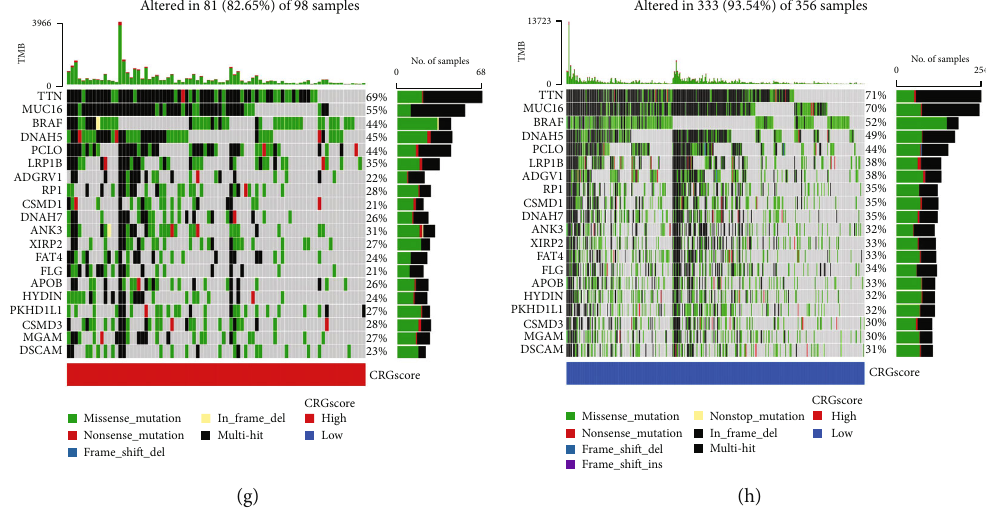
Figure 7: Analysis of the correlation between CRG scores and clinical characteristics. (a – d) K-M survival curves comparing the high CRG score groups to the low CRG score groups across various clinical characteristics. (a) Patients with age > 65 . (b) Patients with age ≤ 65 . (c) Female patients. (d) Male patients. (e) The K-M method determined survival curves for the high and low TMB groups. (f) K-M curves for CM patients, strati fi ed according to TMB and CRG scores. (g) TMB in the group with high CRG scores. (h) TMB in the group with low CRG scores. CRG: cuproptosis-related gene; TMB: tumor mutation burden; CM: cutaneous melanoma; K-M: